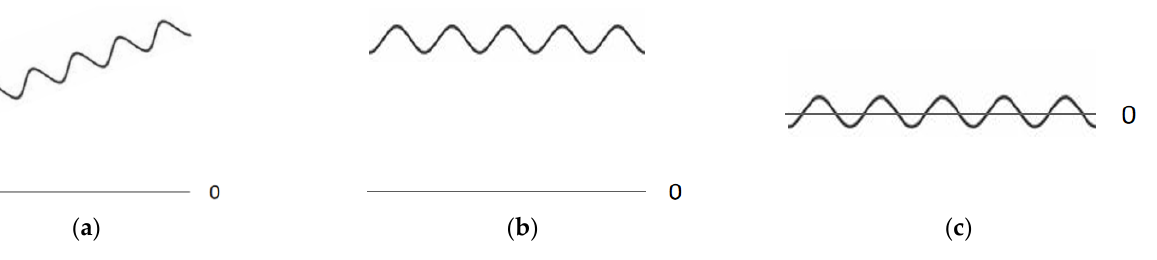
Figure 4. Schematic diagram of profile error elimination: ( a ) original profile, ( b ) elimination of slope, and ( c ) elimination of offset.